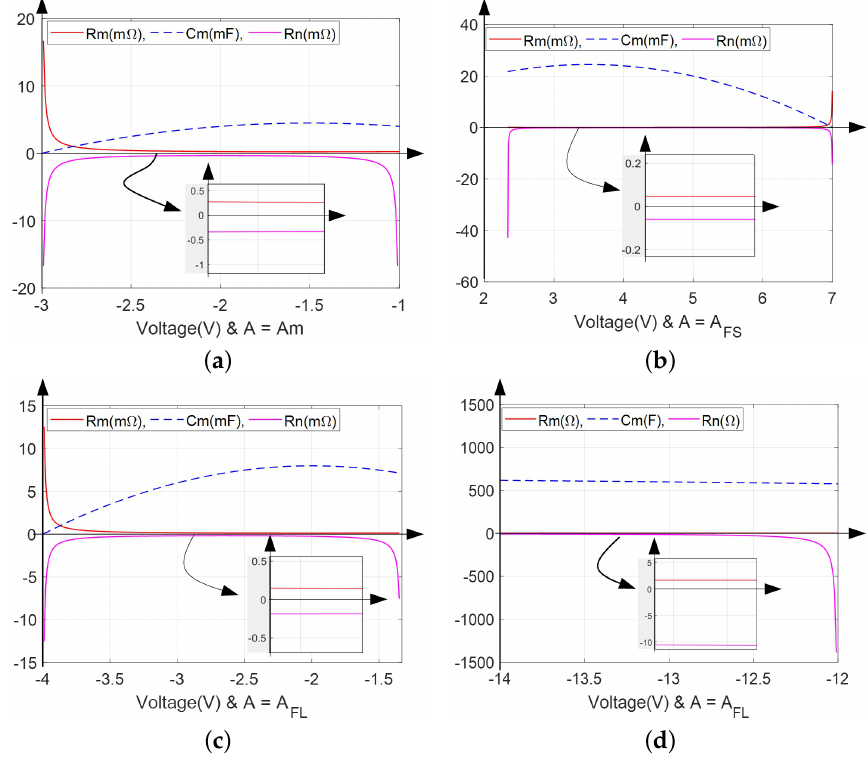
Figure 11. Plot of the small-signal inductance C m and resistances R m and R n over the negative